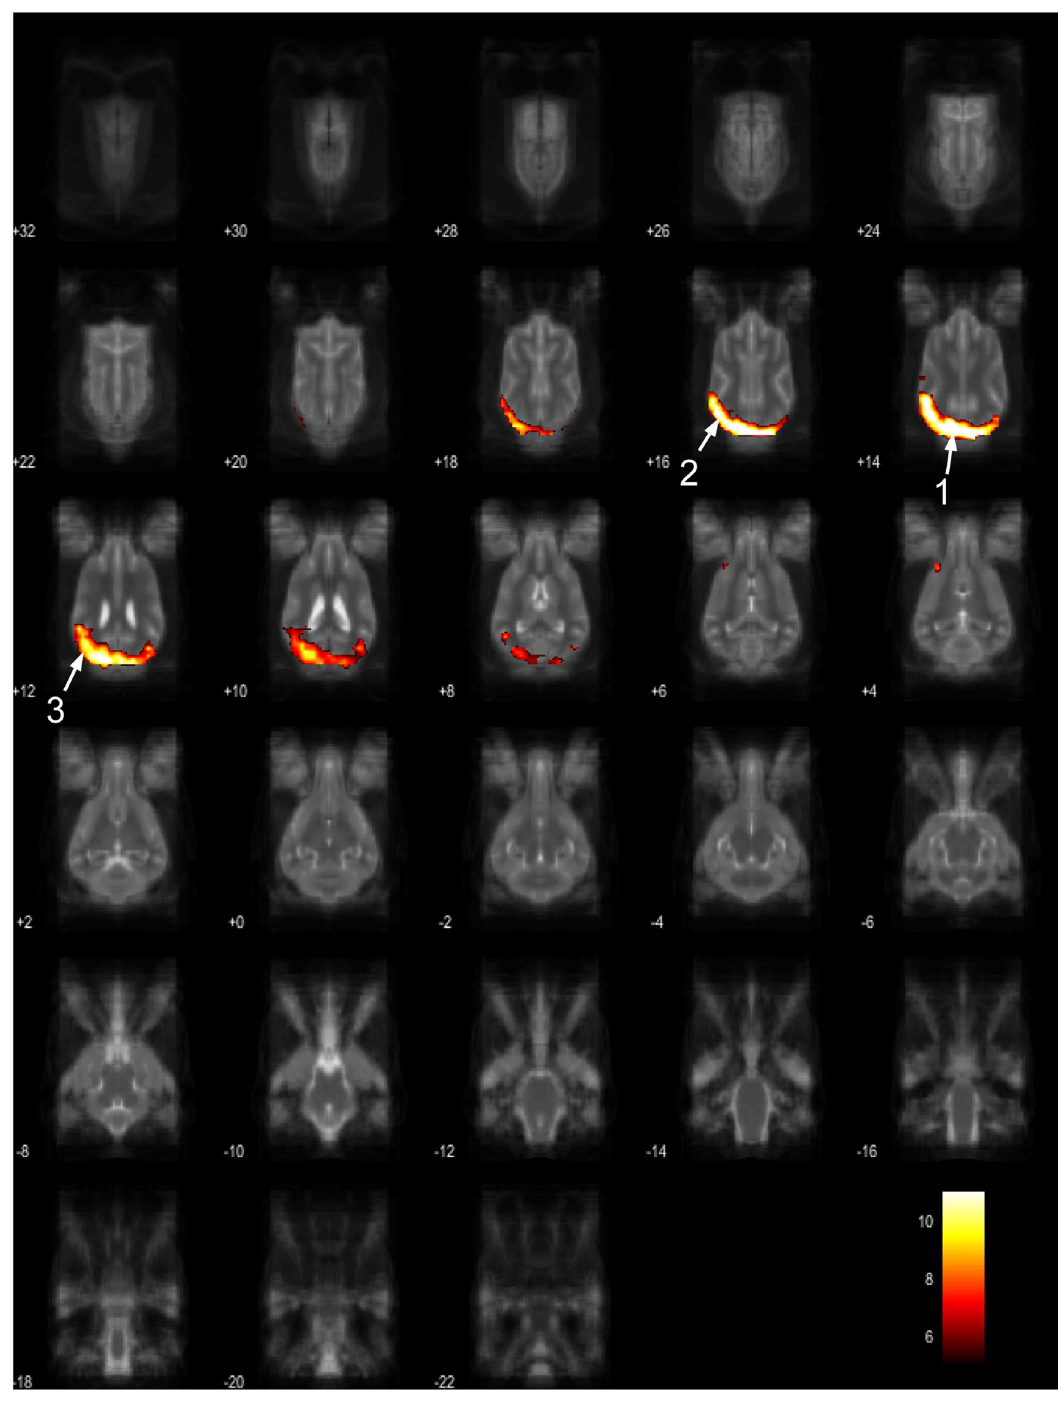
Figure 16. Resting-state network component M from the 15 component gICA. We report the results with a voxel-wise FDR corrected p < 0.001 and cluster treshold of FDR corrected p < 0.005. gICA components are presented as thresholded T-maps, corrected for multiple comparisons, overlaid on the Nitzsche atlas 15 . 1. occipital gyrus, 2. gyrus ectomarginalis, 3. caudal suprasylvian